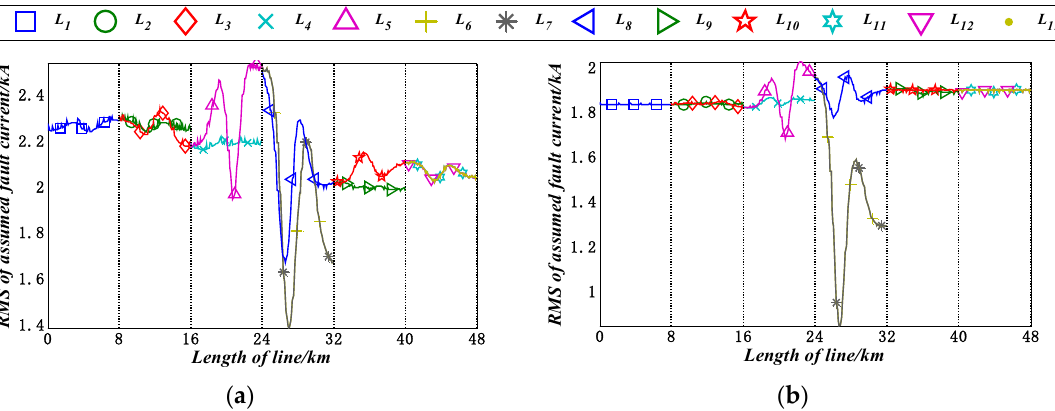
Figure 8. Results of fault line selection for different observers: ( a ) using all observers; ( b ) using observer 2–6.